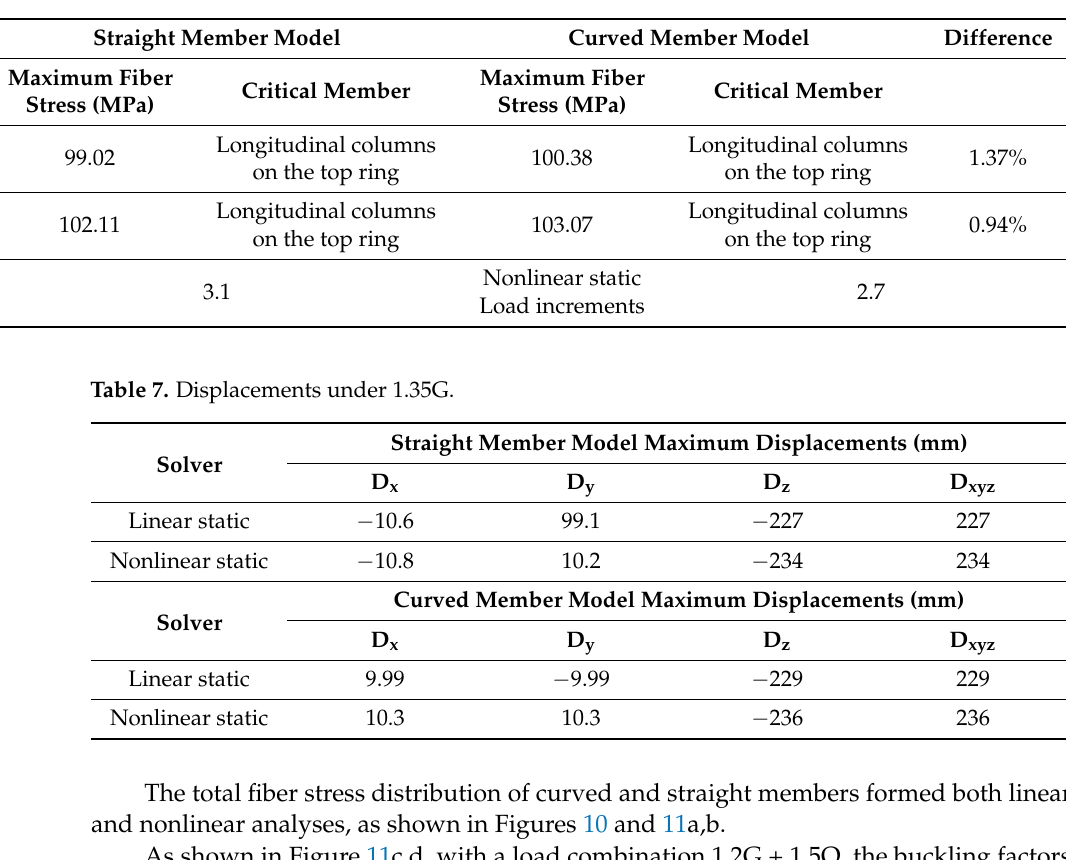
Figure 11. ( a ) Linear analysis of total fiber stress of a curved member model under 1.35G; ( b ) nonlinear analysis of total fiber stress of a curved member model under 1.35G; ( c ) linear buckling analysis of the straight member model under 1.35G; ( d ) linear buckling analysis of the curved member model under 1.35G. 4.1.3. Load Combination: 1.2G + W Table 8 summarizes the total beam fiber stresses of both straight and curved models from both linear and nonlinear analyses under the load combination 1.2G + W. Table 9 summarizes the displacements of straight and curved models from both linear and non- linear analyses under the load combination 1.2G + W.